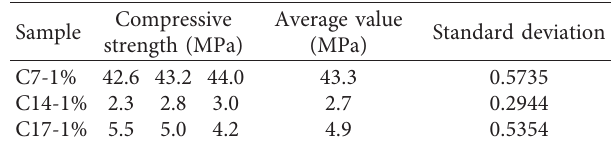
Figure 13: (a) TG curves of the three samples; TG, DTA, DTG curve of the C7-1% (b), C14-1% (c), and C17-1% (d) samples. Table 2: Average value and standard deviation of compressive strength of the sample.